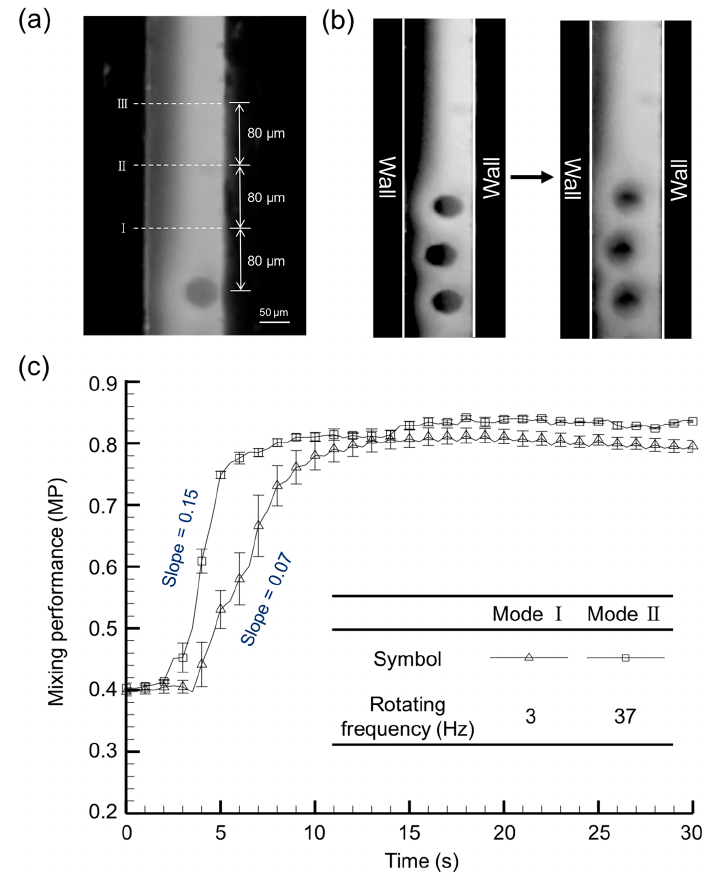
Figure 3. ( a ) Three zones, situated at distances of 80, 160 and 240 µ m from the last cilia position, respectively, were selected to quantify the mixing performance; ( b ) Pictures of the flow field when the cilia are static and rotating at frequency of 37 Hz; ( c ) Time dependent micro-mixing performance (MP) in two distinctive artificial cilia beating modes (e.g., 3 and 37